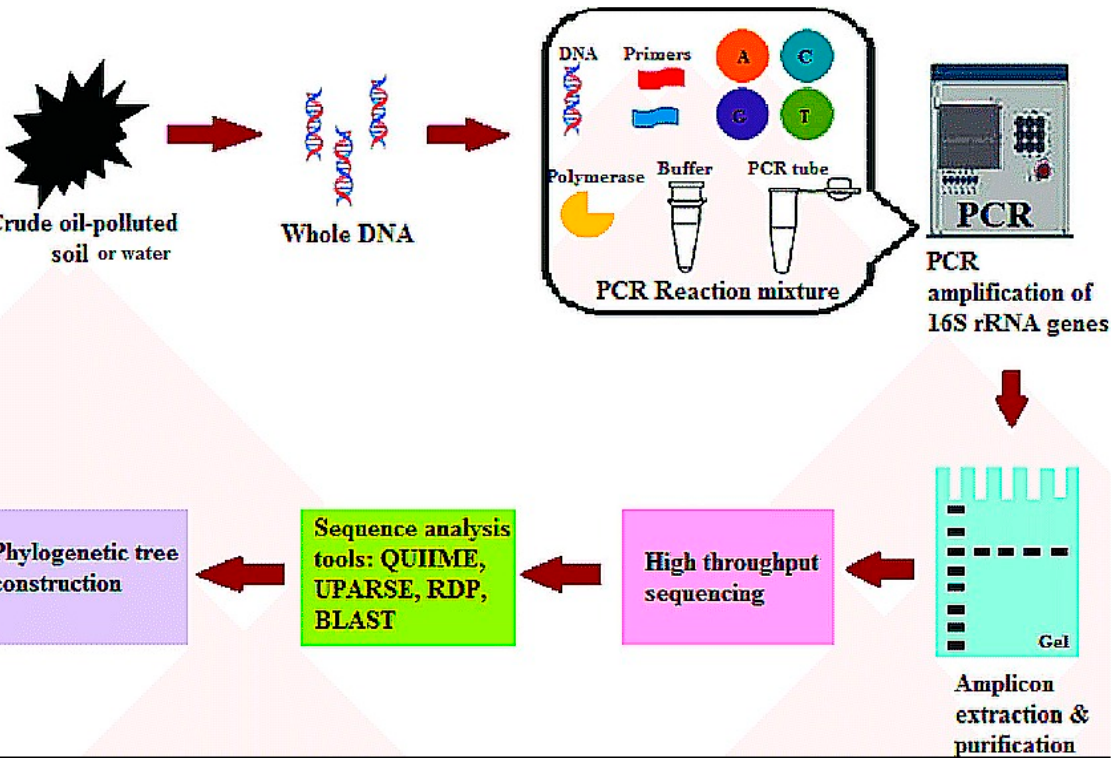
Figure 4. Schematic representation of microbial community analysis of crude oil-polluted soil using high throughput sequencing methods. Source: Raju & Scalvenzi [21].